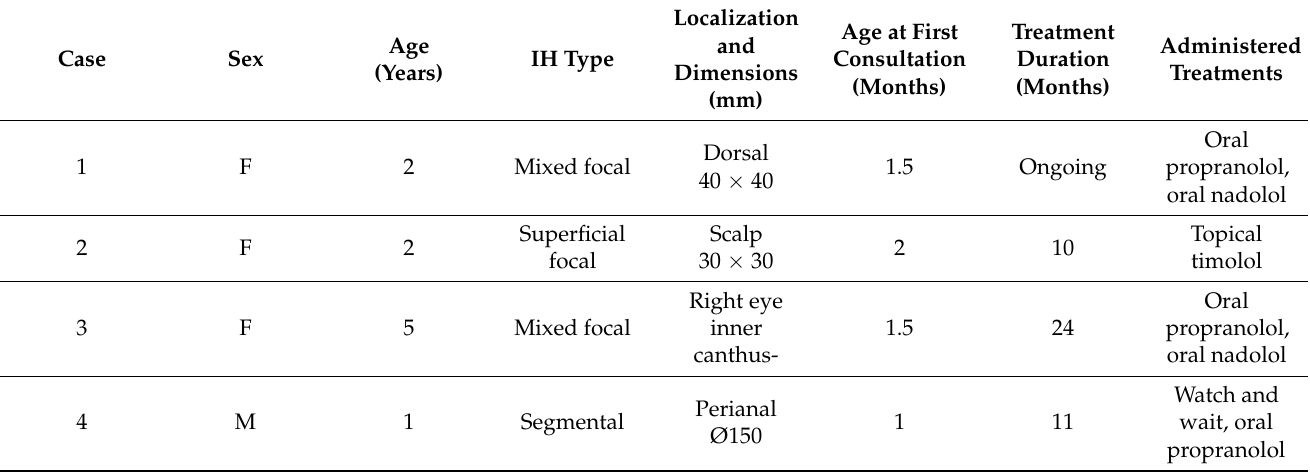
Table 3. Clinical and demographic characteristics of the nine patients with IHs monitored using